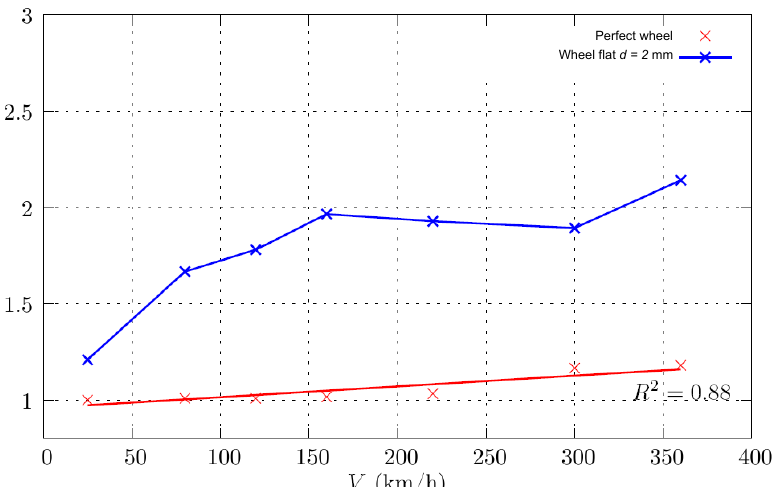
Figure 8. Dynamic amplification factor for the rail vertical displacement: perfect wheel vs. flat wheel ( d = 2 mm), ballasted